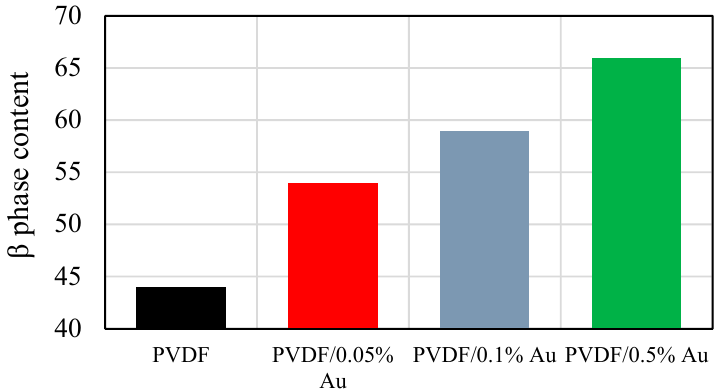
Figure 6. The β phase content of PVDF and PVDF/Au nanocomposite films.